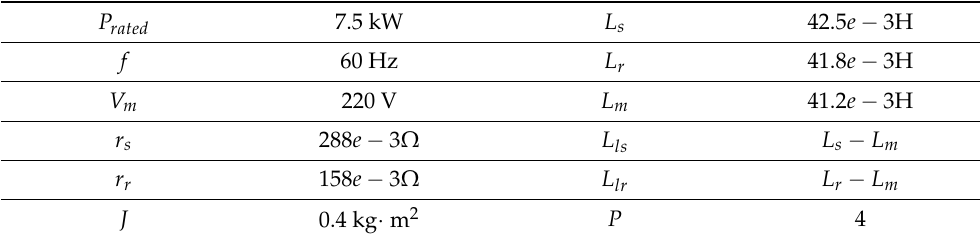
Table 1. Parameters used for induction motor